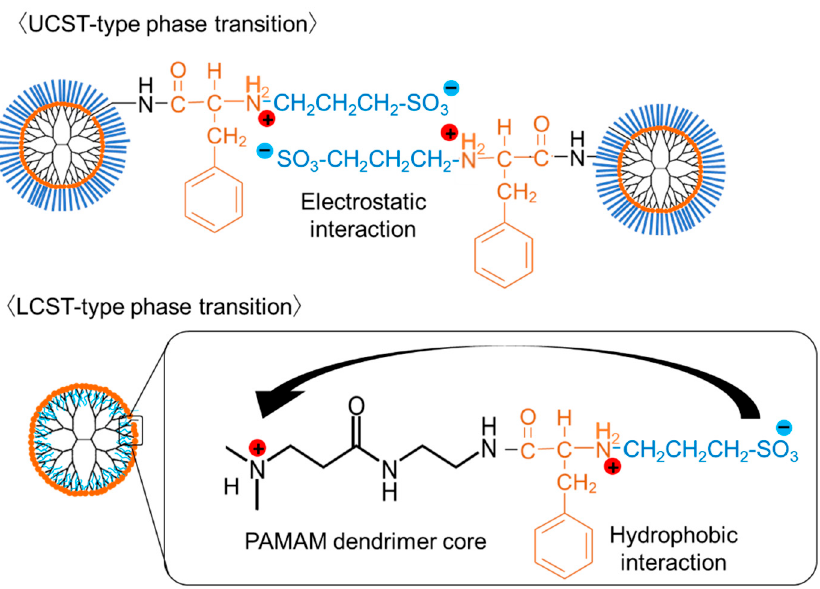
Figure 5. Possible phase transition mechanisms of PAMAM-Phe-SO 3 Na.